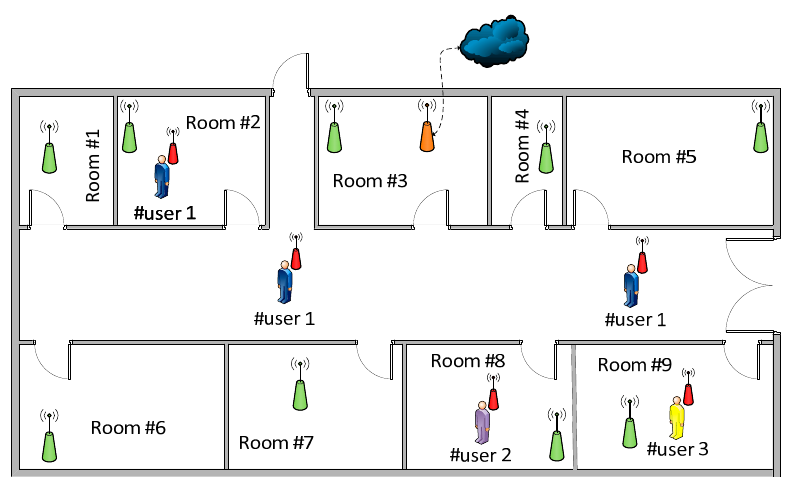
Figure 5. Indoor wearable wireless sensor network (W-WSN) deployment in the application test scenario (dimensions: 50 m × 15 m).